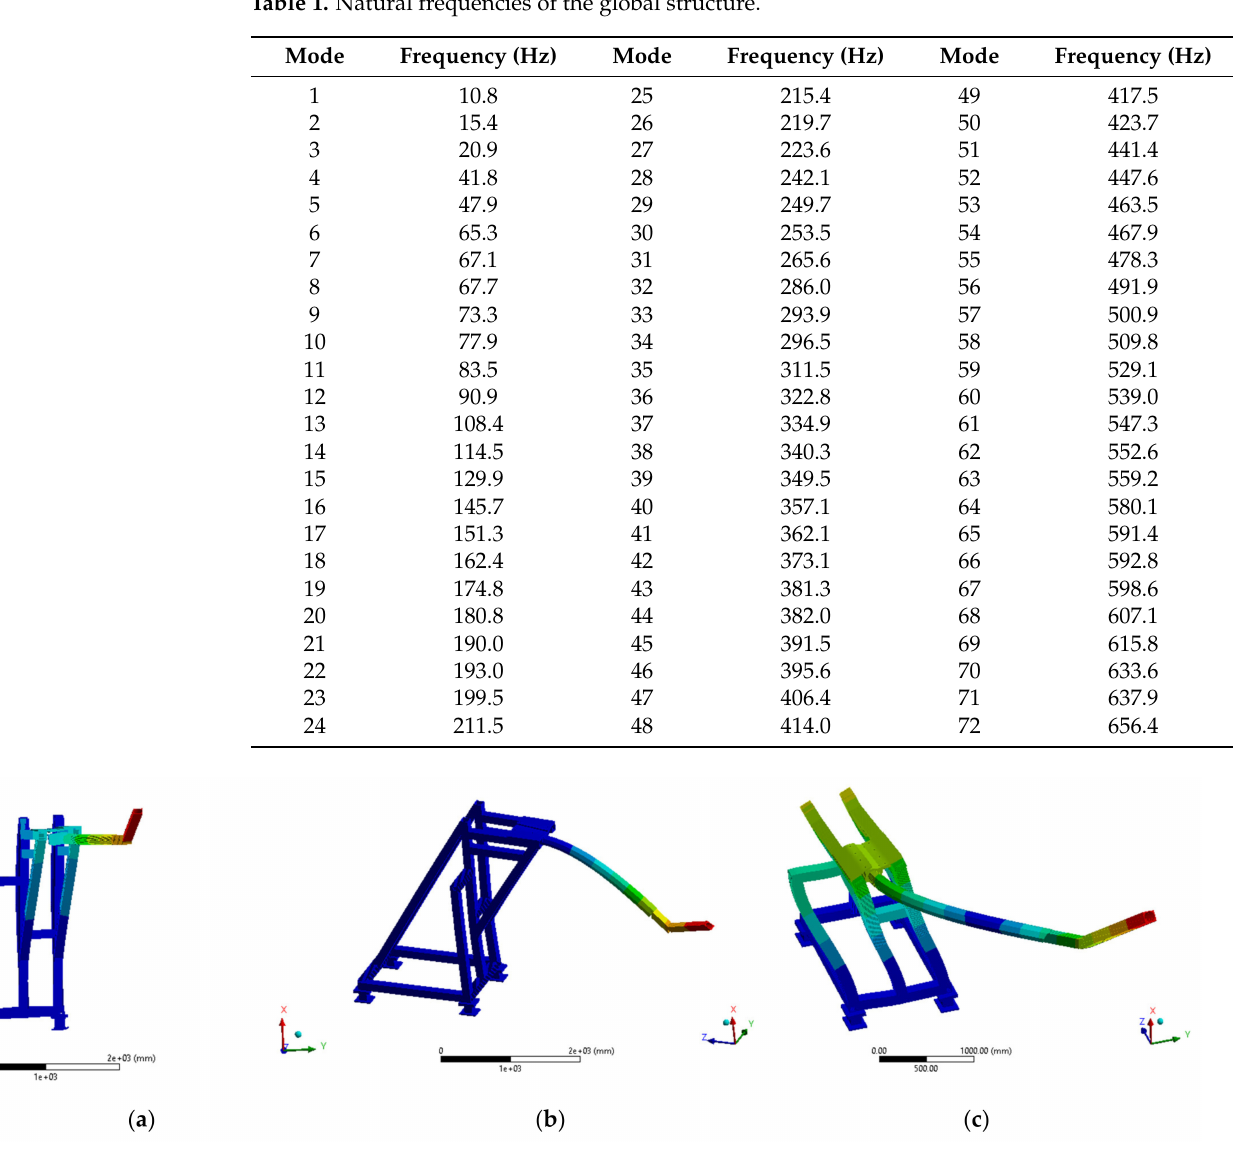
Figure 13. ( a ) First mode representation—F 1 = 10.8 Hz; ( b ) second mode representation—F 2 = 15.4 Hz; ( c ) third mode representation—F 3 = 20.9